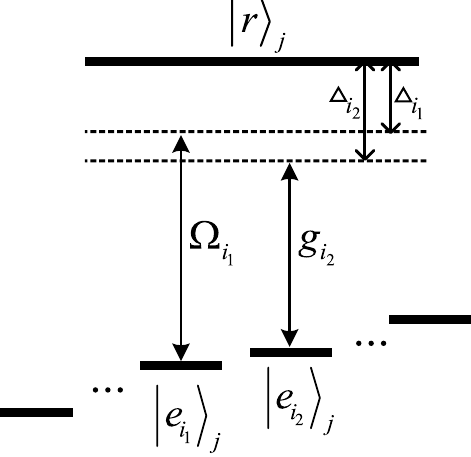
of the j -th atom is coupled to the i j 1 is driven by a classical field i j 2